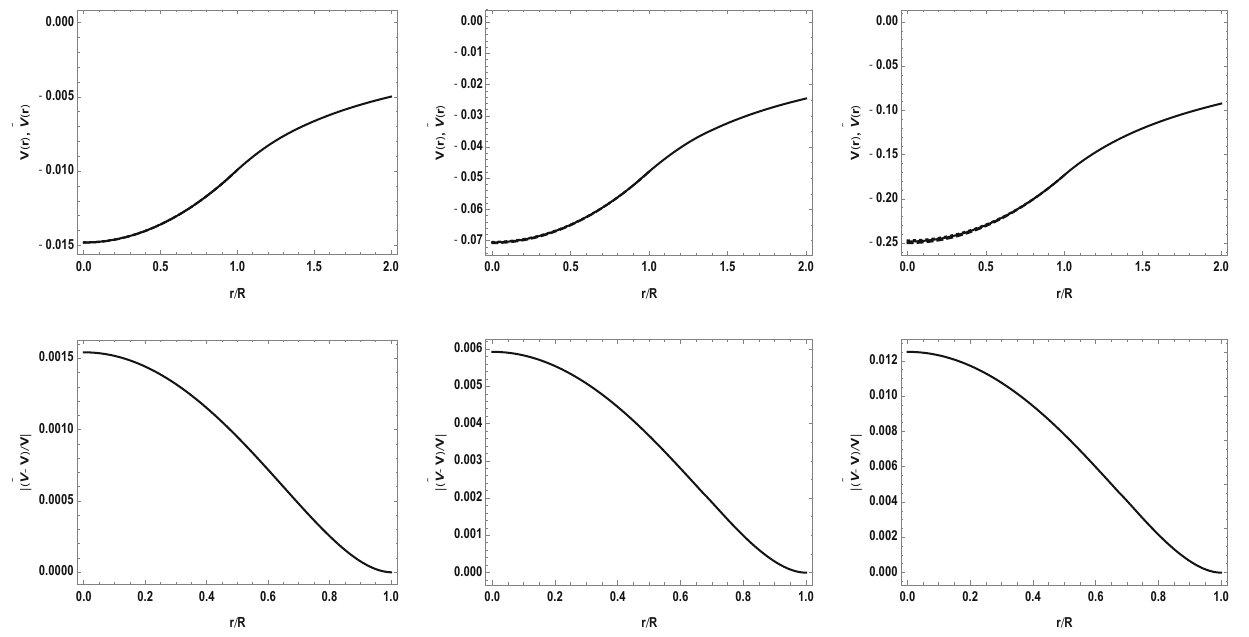
panels: absolute value of the relative difference (cid:10) = | ( ˜ V in − V in )/ V in